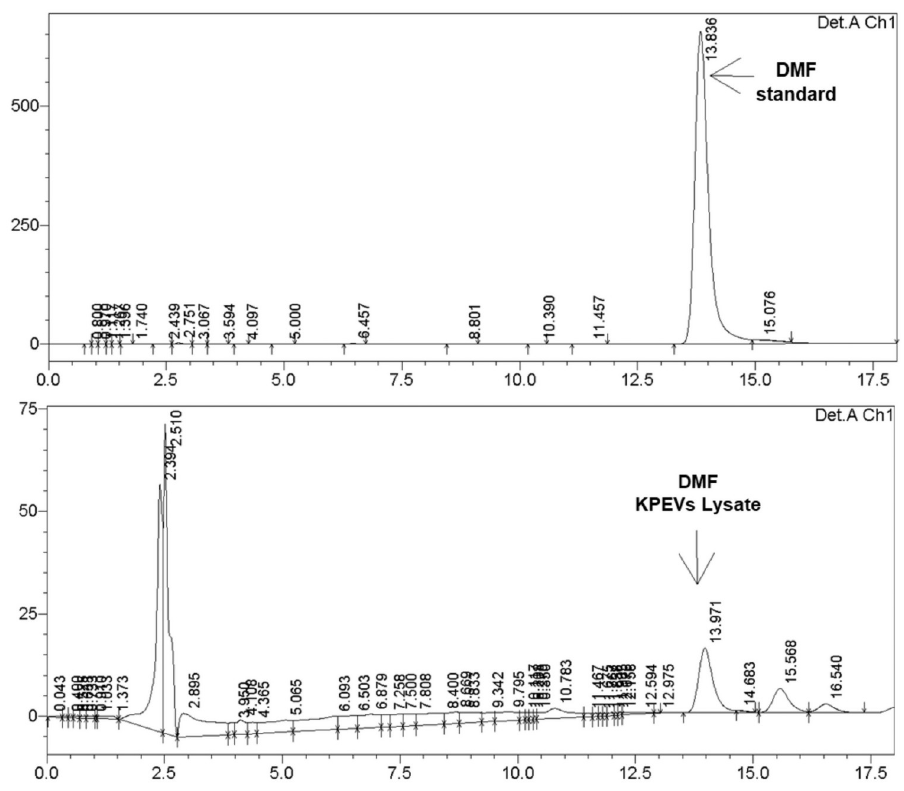
Fig 2. Qualification of 5,7-Dimethoxyflavone (DMF) content in KPEVs using HPLC. The DMF in KPEVs lysate samples was identified by comparison to the DMF reference standard and quantified by the DMF standard curve.